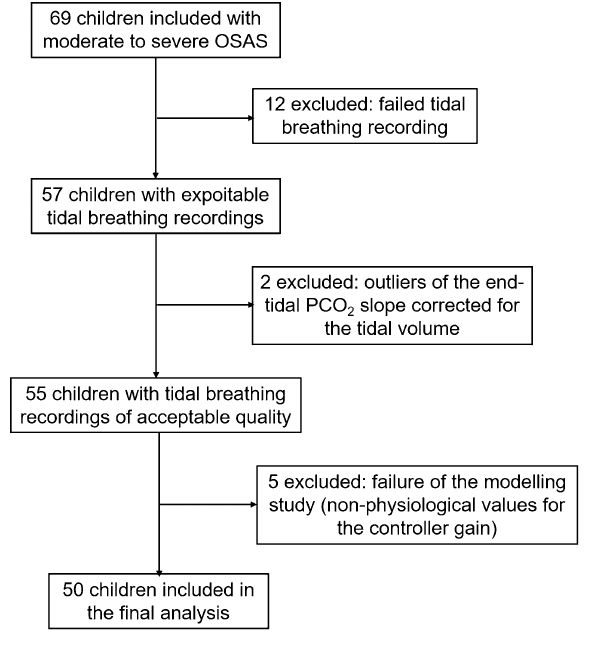
Figure 2. Patient flow